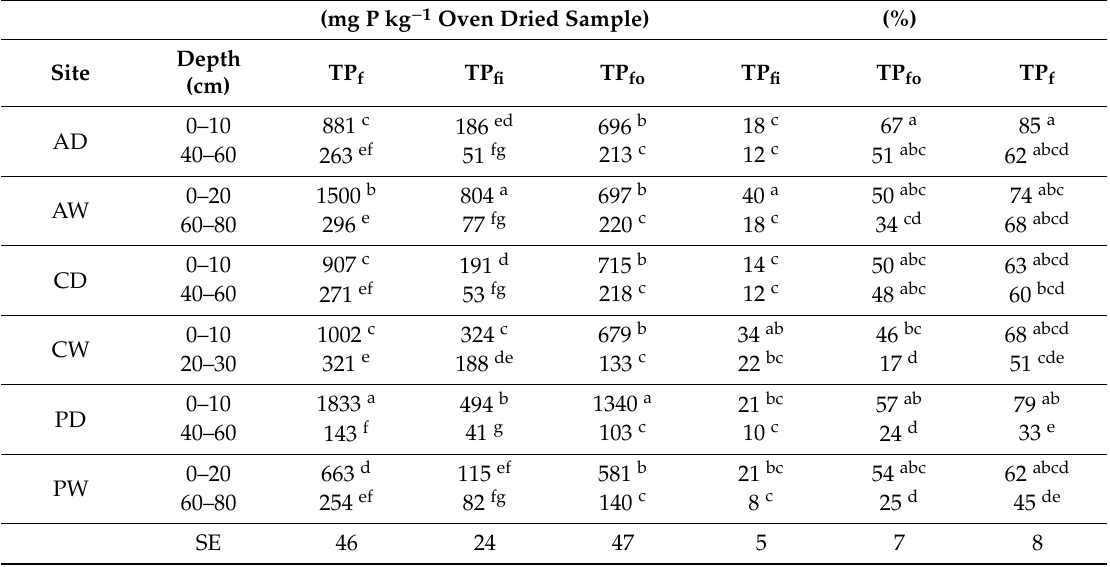
Table 3. Phosphorus fractions recovered by single step NaOH-Na 2 EDTA (NaOH-EDTA) extraction.